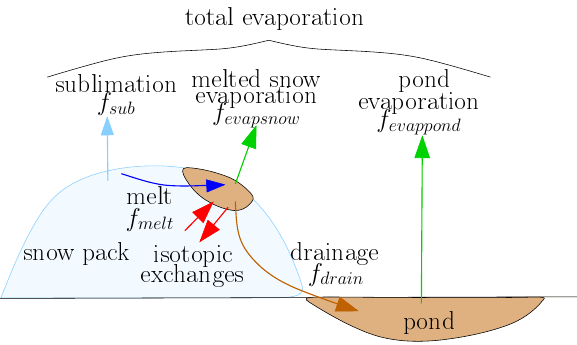
Fig. 2. Schematic depiction of the surface water balance in a re- gion of snow pack loss. Total evaporation is the sum of sublimation, evaporation from melt water in the snow, and evaporation from melt water in ponds on the soil. It is assumed that additional evaporation from preexisting soil water can be neglected. Melted snow may re- main in the snow pack or drain to (muddy) ponds. Isotopic fraction- ation occurs during exchange between the snow pack liquid and ice, and during evaporation from liquid